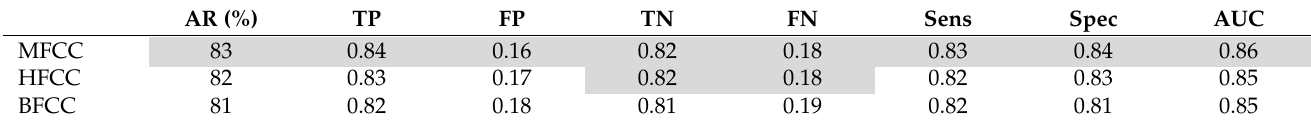
Table 6. Summary of the results of the RF model with MFCC, HFCC and BFCC filters, by employing the first four moments of their distributions (mean- µ , standard deviation-STD, skewness-skew and kurtosis-kurt), ∆ and ∆∆ . 10-cross-validation with 20,000 laughs (18,000 training and 2000 test in 10 epochs). AR, accuracy rate; TP, true positive; FP, false positive; TN, true negative; FN, false negative; Sens, sensitivity; Spec, specificity. Note that the three rows correspond to the 4th, 8th and 12th row of Table